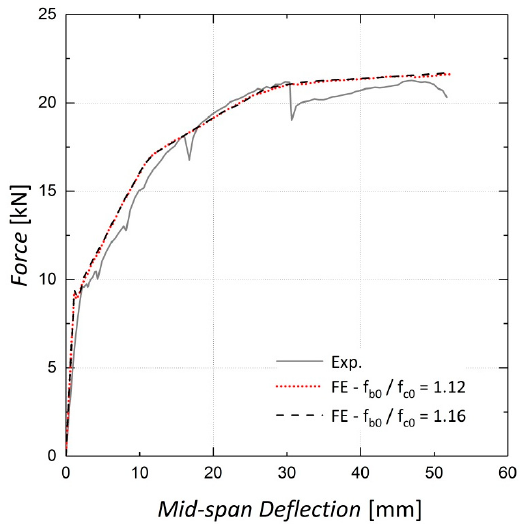
Figure 6. Sensitivity of results to f b0 /f c0 —Beam 10.